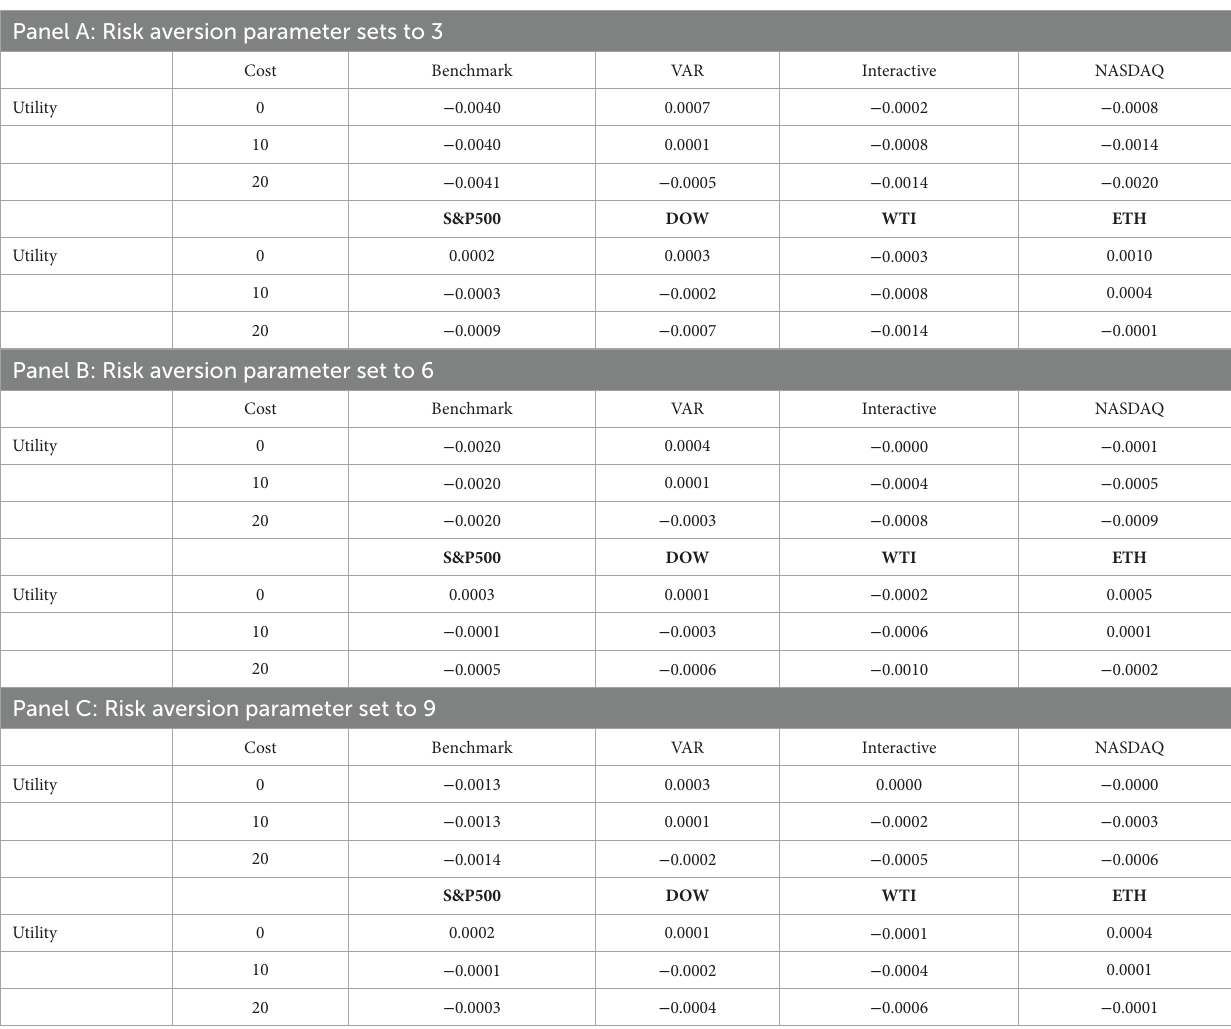
TABLE 9 Portfolio performance measures: the perspective of utility. Panel A: Risk aversion parameter sets to 3